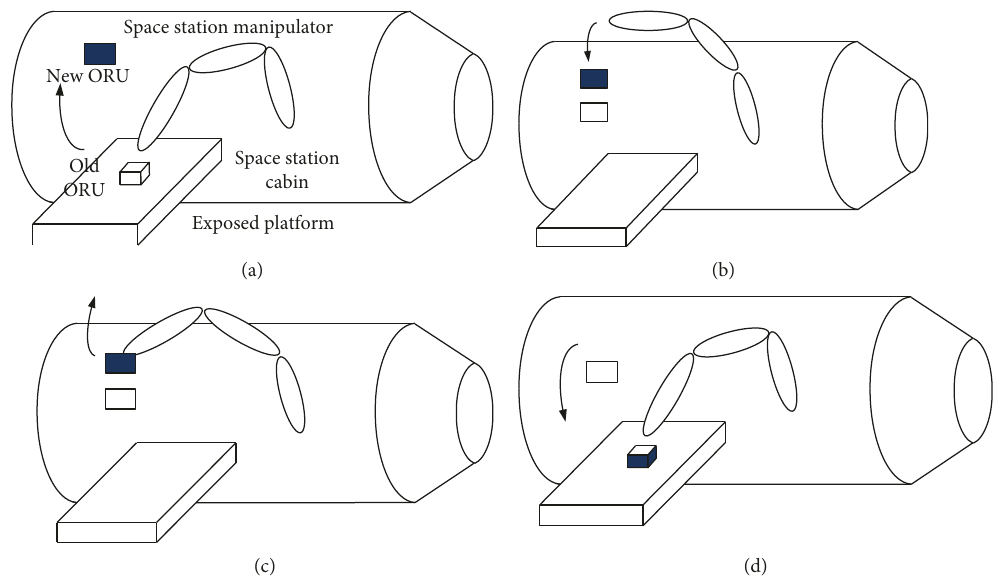
Figure 1: ORU replacement fl ow: (a) old ORU extracting, (b) old ORU inserting, (c) new ORU extracting, and (d) new ORU